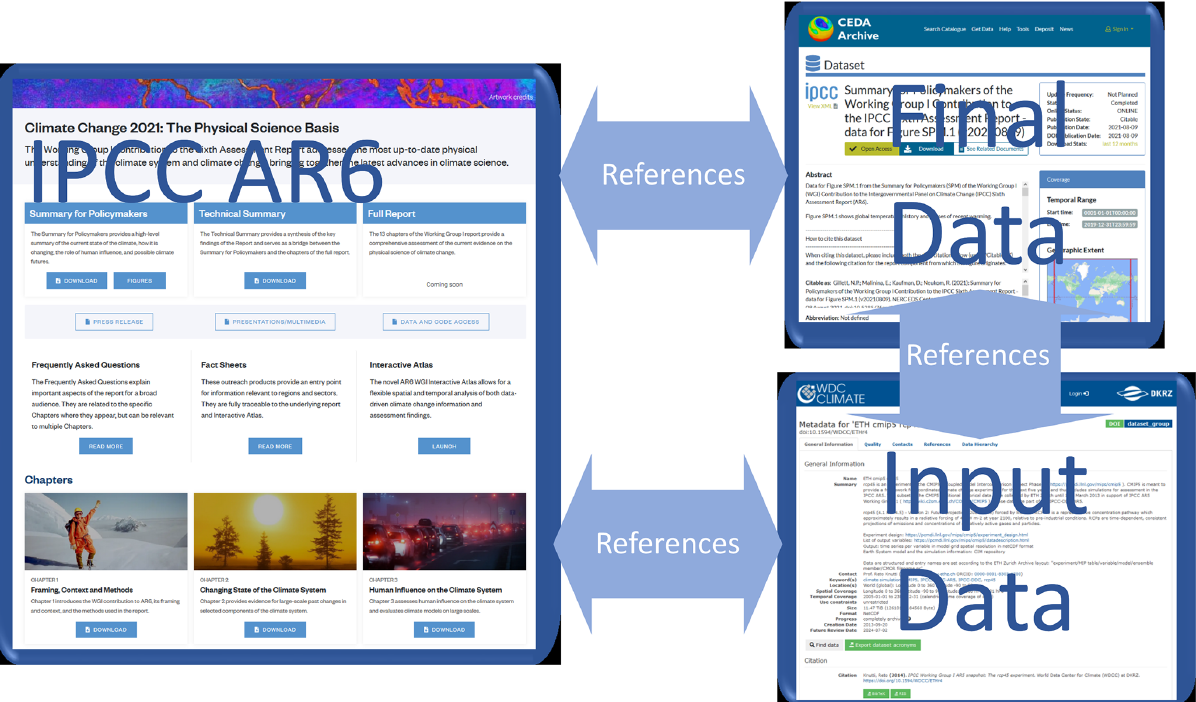
Figure 5. Schematic vision of the bidirectional references between report, input data, and final datasets in IPCC AR6 enabling users to navigate among these AR6 results (screenshots from IPCC, CEDA, and DKRZ web